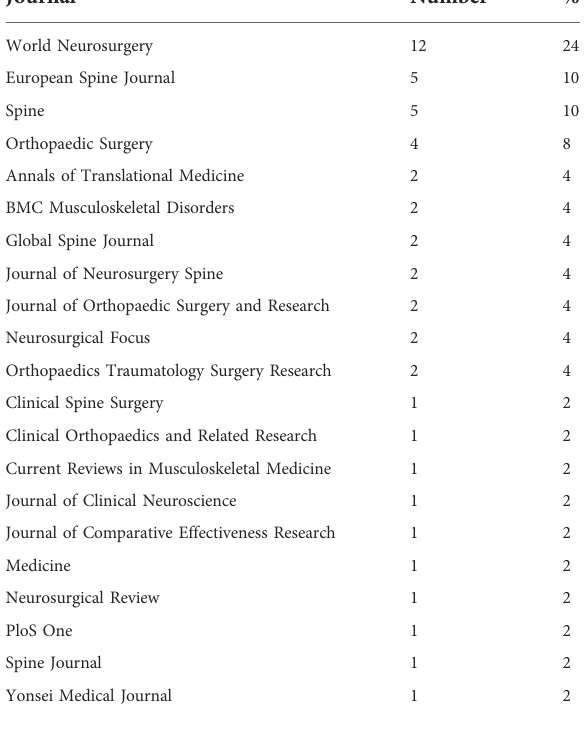
TABLE 3 Journal distribution of the 50 top cited articles on pre-psoas oblique lumbar interbody fusion. Journal